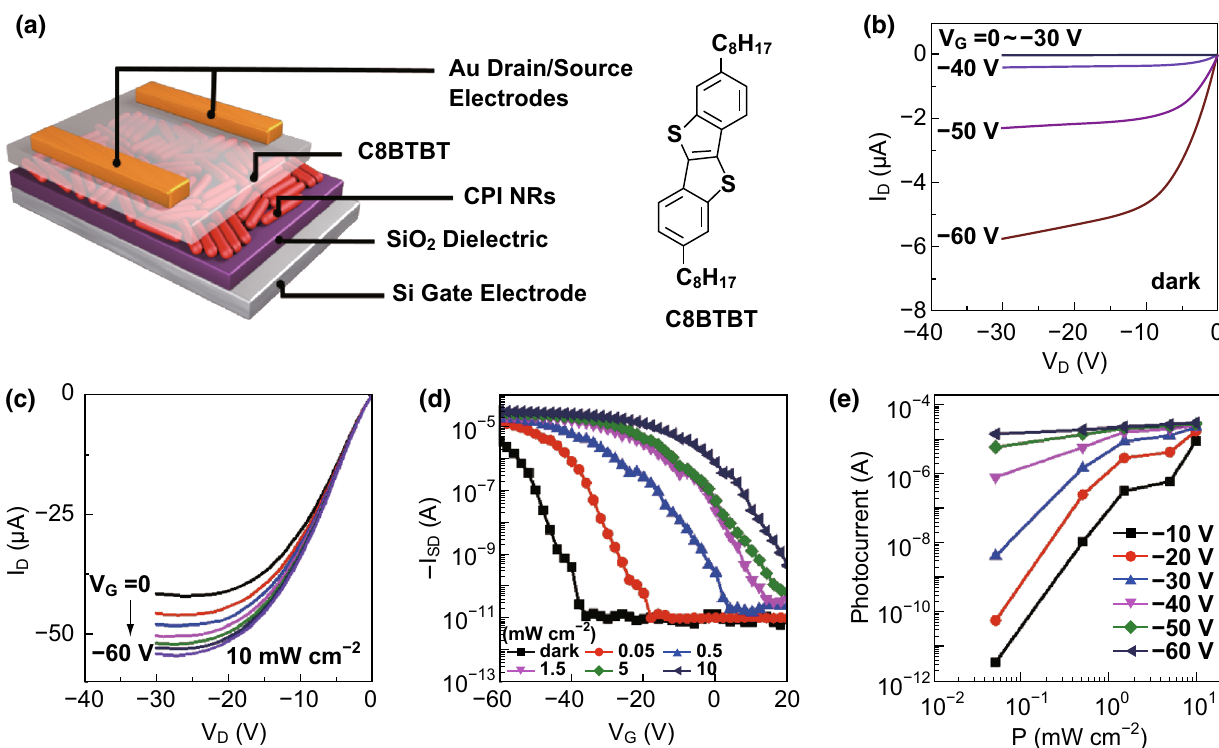
Fig. 2 a Schematic diagram of the C8BTBT/CsPbI 3 nanorod-based phototransistor. I D – V D transistor characteristics of the hybrid phototransistor under a fixed illumination power intensity: b in the dark state and c under a white-light illumination of 10 mW cm - 2 . d Transfer characteristics ( V D = - 30 V) under different illumination power densities. e Photocurrent as a function of the illumination power density for different gate Fig. 3a. It can be fitted with D V = a P b , yielding th b & 0.24, where b is the power factor. The well-fitted line indicates that the shift of the threshold voltage was attrib-